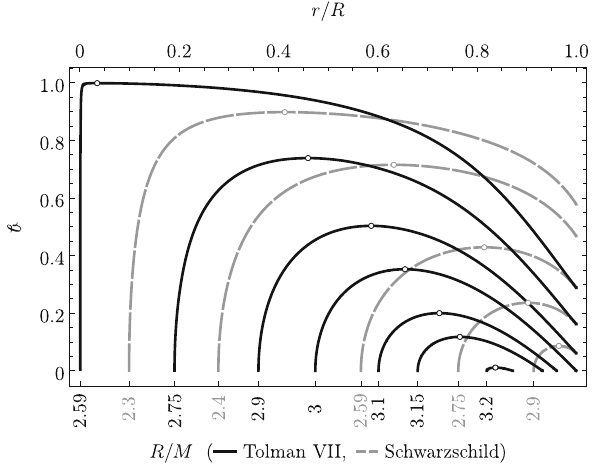
Fig. 8 Local trapping efficiency in extremely compact Tolman VII spacetime (black) compared to local trapping efficiency in extremely compact Schwarzschild spacetime